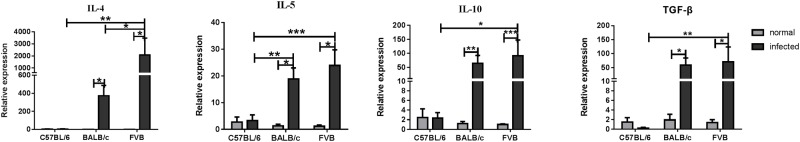
The levels of mRNA of IL-4, IL-5, IL-10 and TGF-β cytokines in the liver of normal and Clonorchis sinensis-infected mice.mRNA of IL-4(A), IL-5(B), IL-10(C) and TGF-β(D) cytokines in the liver were determined by quantitative RT-PCR. All data are mean±SEM of four or more independent experiments. * = P <0.05, ** = P <0.01, *** = P <0.001.